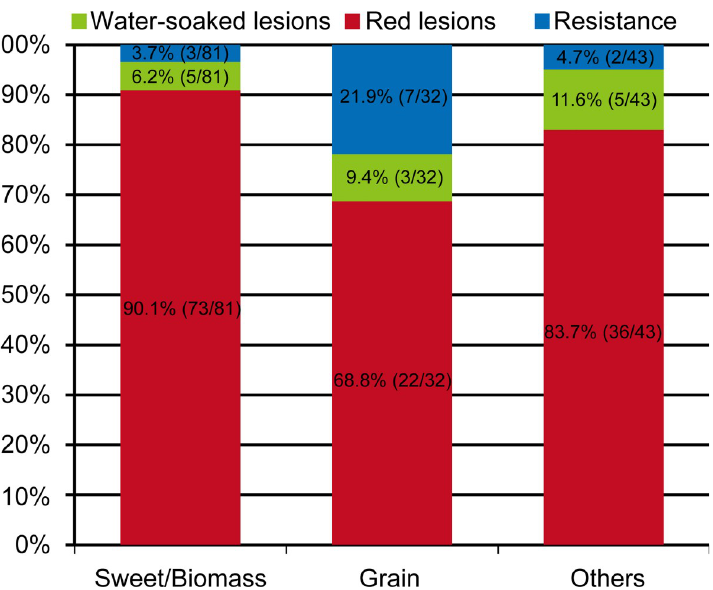
Fig 2. Summary of the Xvh -disease phenotypes in 156 sorghum genotypes. Percentage and ratio of each disease phenotype for the different types of sorghum